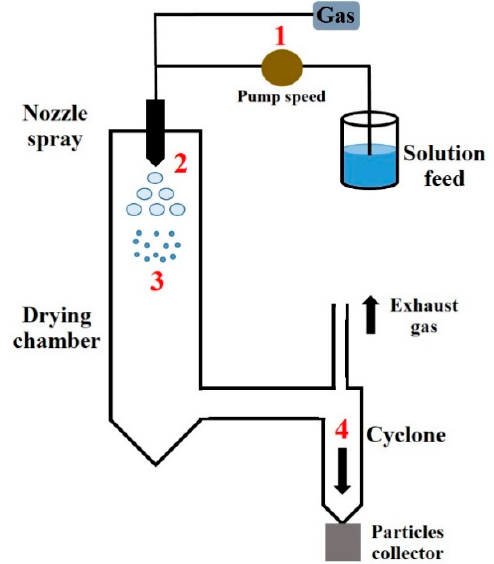
Figure 7. Four different steps of the spray-drying process. ( 1 ) The solution feed is pumped into the drying chamber according to the pump speed and atomized with the gas through a nozzle. ( 2 ) The drying of droplets occurs after the atomization. ( 3 ) Dry powder is formed in the drying chamber. ( 4 ) The separation of powder and air is induced by a cyclone in the bottom of the equipment and final powder is collected in a recipient. Table 3. Influence of the main spray-drying parameters on particle powder properties.